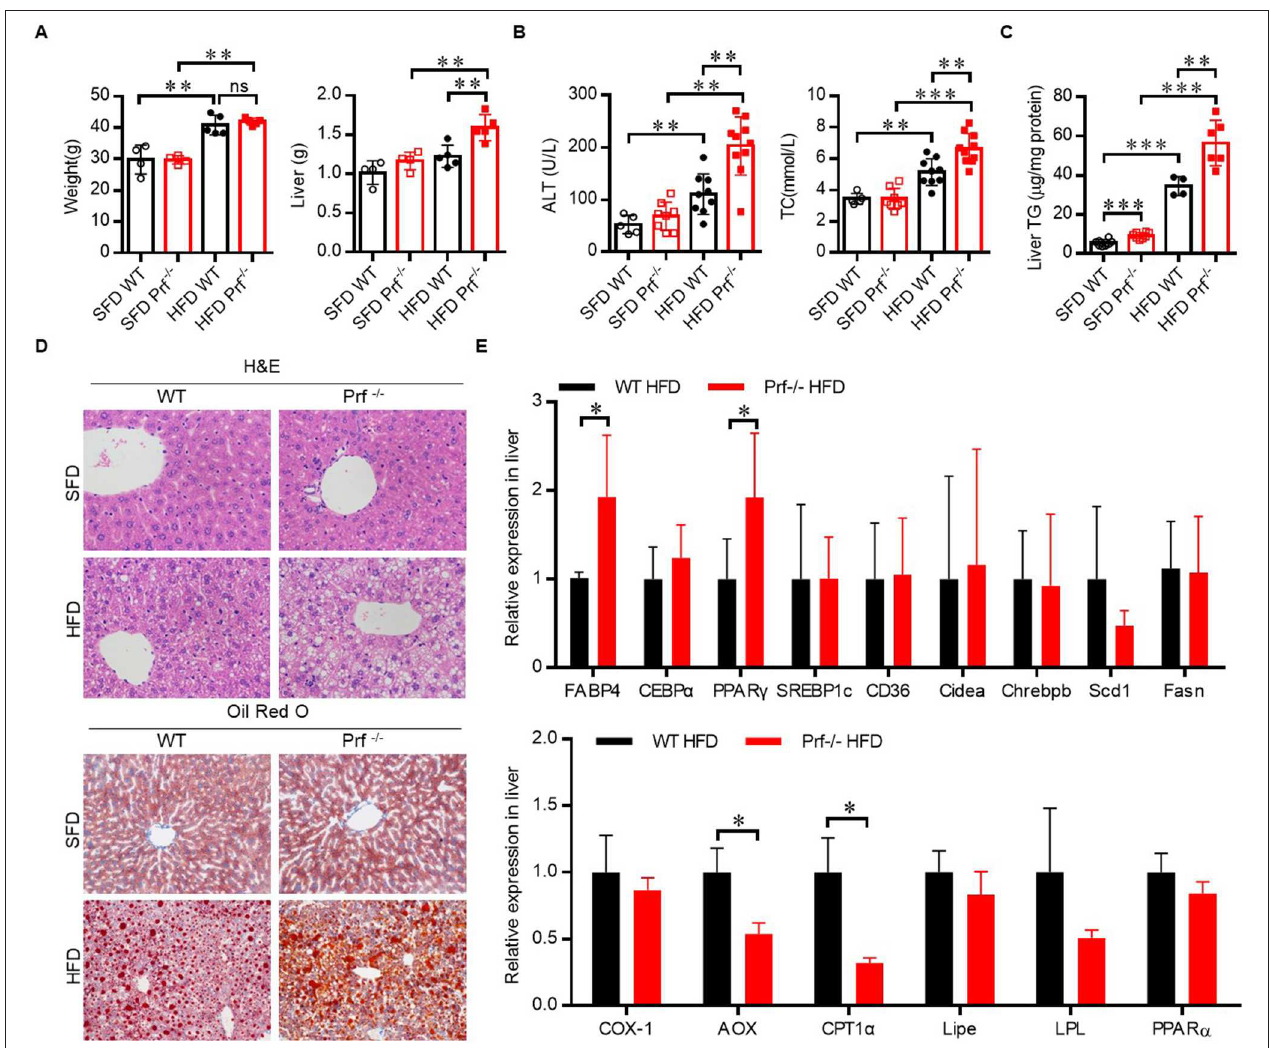
FIGURE 2 | Perforin deficiency aggravates HFD-induced liver injury and steatohepatitis. WT and Prf − / − mice were fed SFD or HFD for 10 weeks at 6–8 weeks of age. (A) Body weight (left panel) and liver weights (right panel) ( n = 4–5), (B) measurements of serum ALT (left panel) and cholesterol levels (right panel) ( n = 5–10), and (C) measurements of liver TG content ( n = 4–8). (D) Representative images of liver sections stained with H&E and Oil red O. (E) Expression levels of lipogenic genes (top) and fatty acid oxidation genes (bottom) in the liver, relative to Hprt expression levels ( n = 4–9). The data shown in each panel of the figures were collected from a single experiment, and each experiment was repeated for at least three times and rendered consistent results. Means ± SEM, * p < 0.05; ** p < 0.01, *** p <